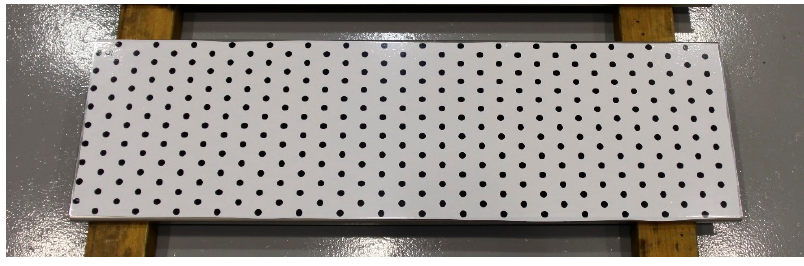
Figure 13. Target pattern over the reflector surface of the facet for the photogrammetry process.